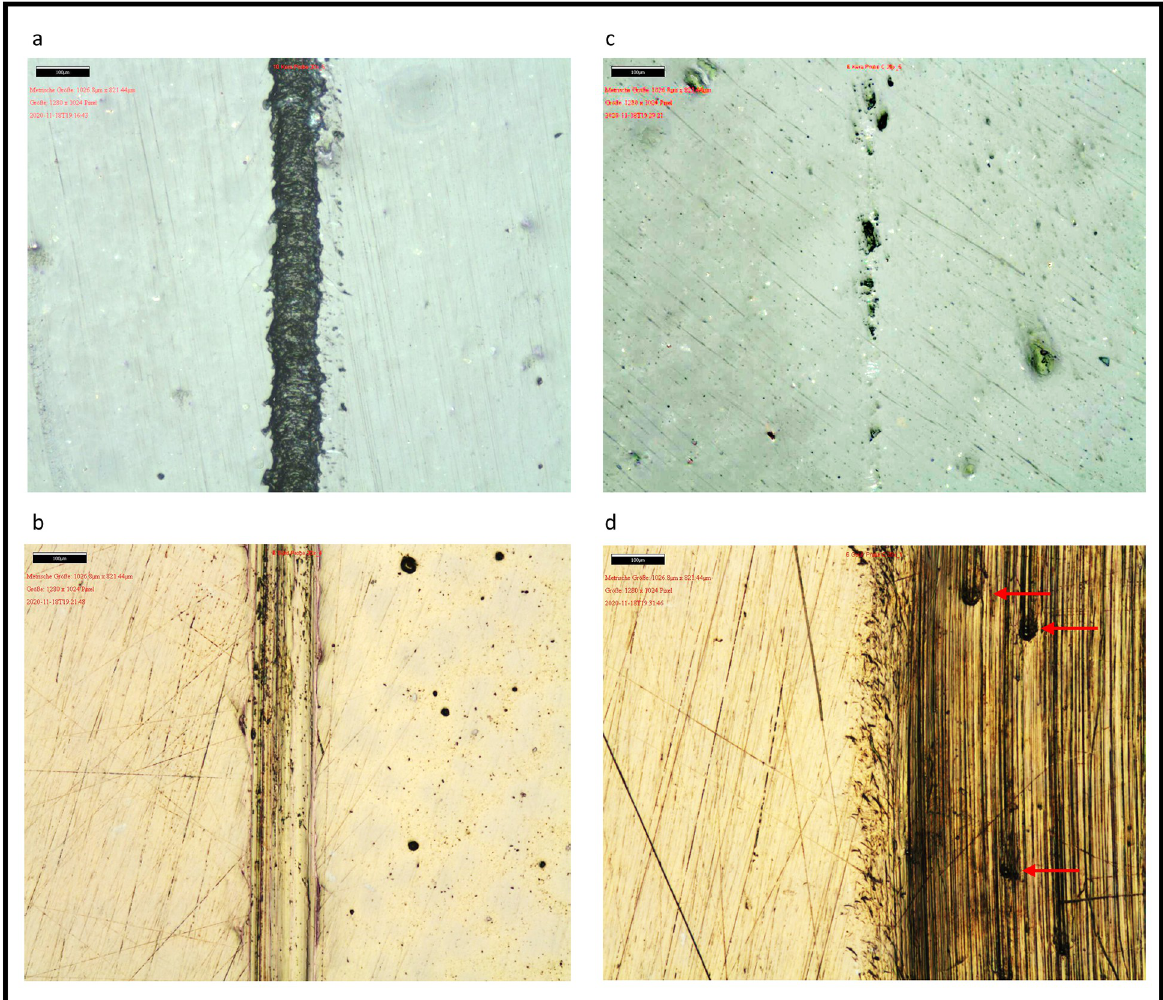
Fig 3. Probes following air polishing (a-b) and following prophylaxis paste (c-d). a–ceramic (left untreated, right treated); b–gold (left untreated, right treated); c–ceramic (left untreated, right treated); d–gold (left untreated, right treated); Red arrows mark pitting after treatment with prophylactic